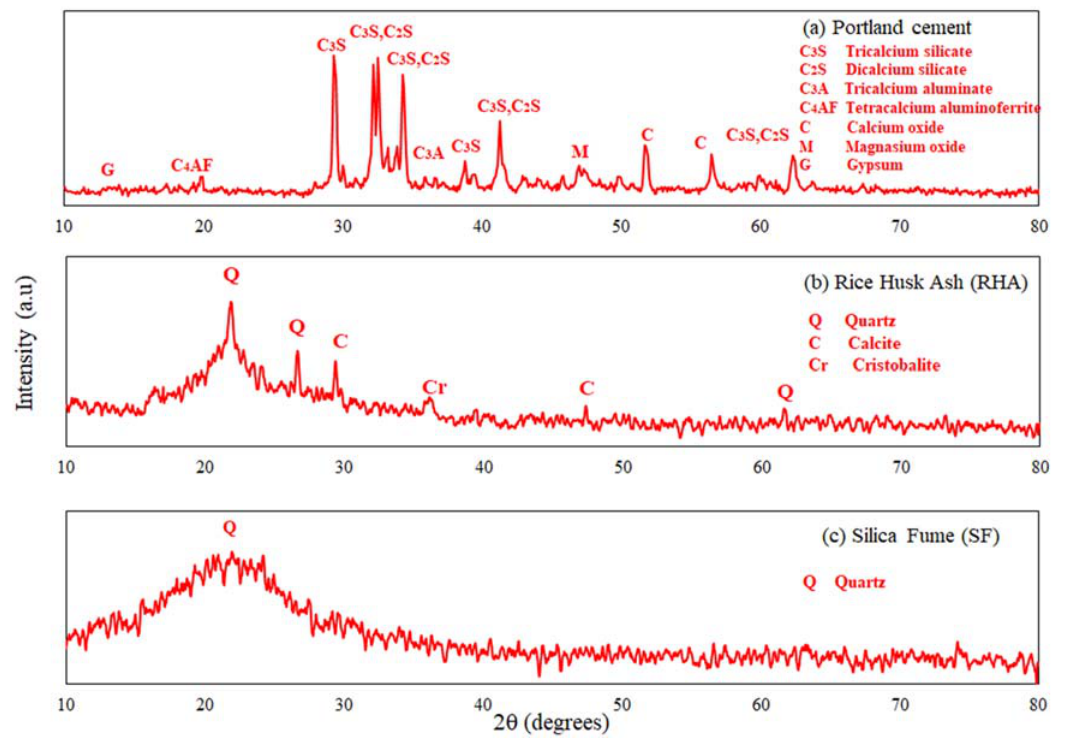
Figure 3. XRD Analysis of ( a ) Cement ( b ) Rice Husk Ash and ( c ) Silica Fume.